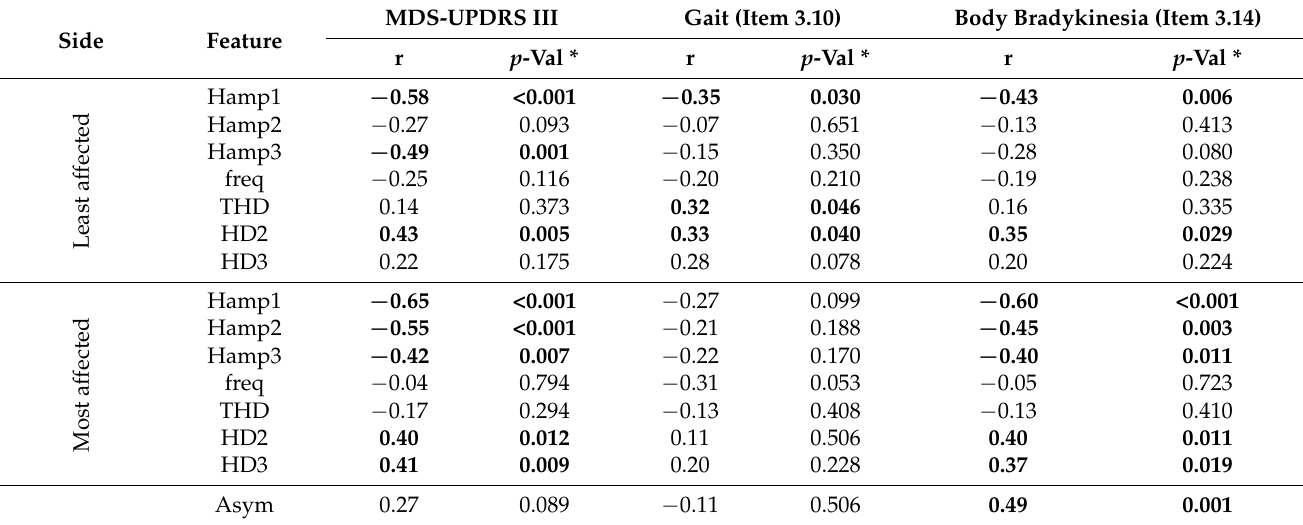
Table 4. Spearman’s rank correlation coefficients for the “most affected” and “least affected” sides in de novo parkinsonian patients.